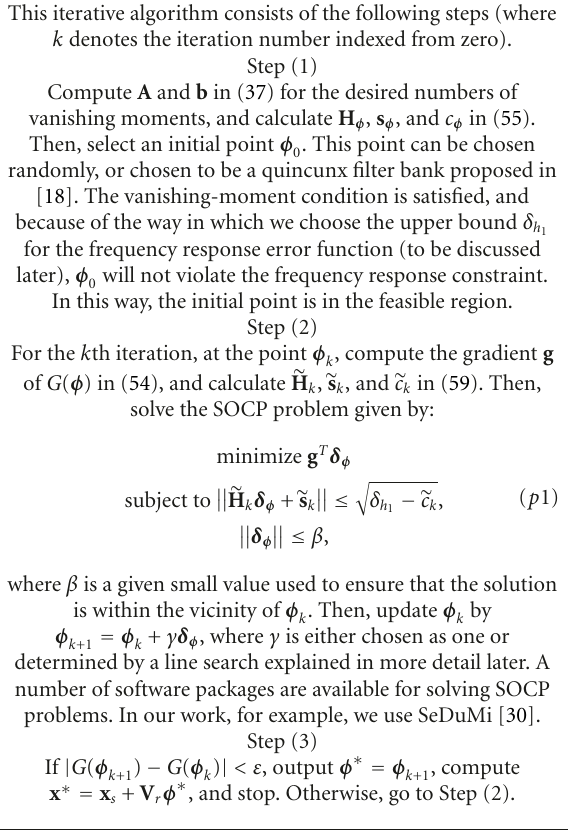
Algorithm 1: Two-lifting-step